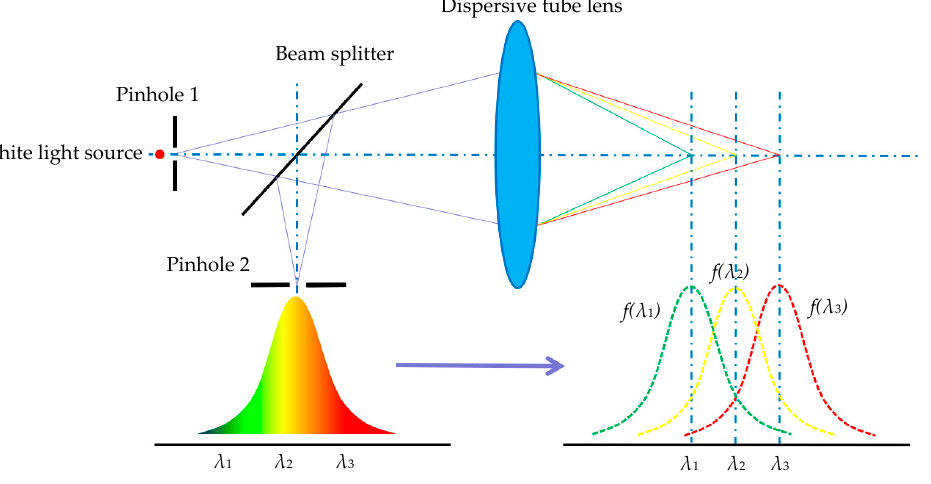
Figure 4. Schematic diagram of the intensity response.